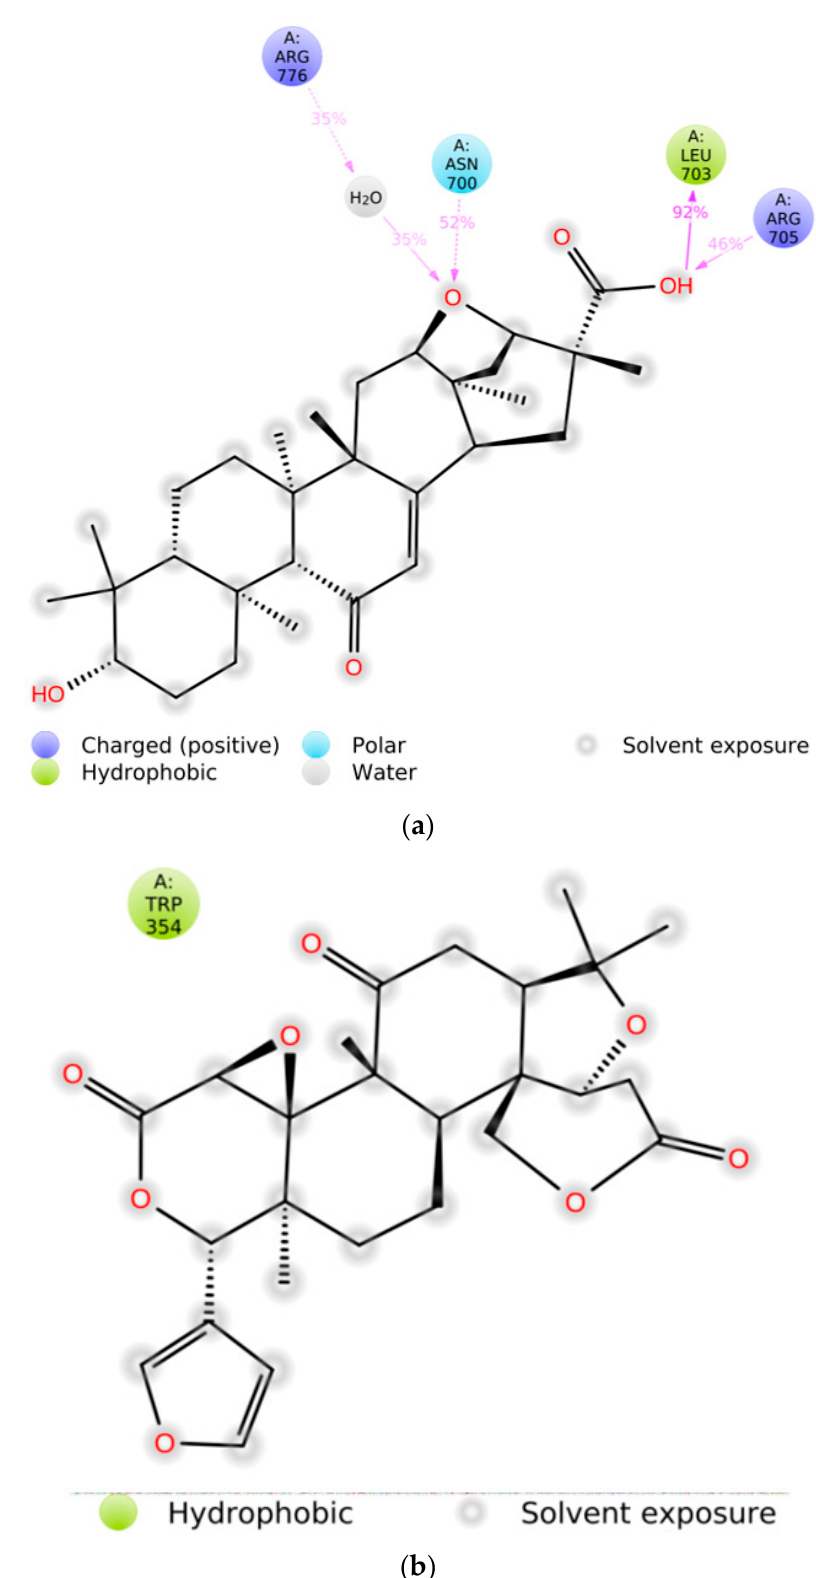
Figure 10. Interactions of ligand atoms to the amino acids of the receptor proteins. ( a ) Interaction of liquoric acid atoms with EGFR protein residues; ( b ) interaction of limonin atoms with caspase-9 protein residues.